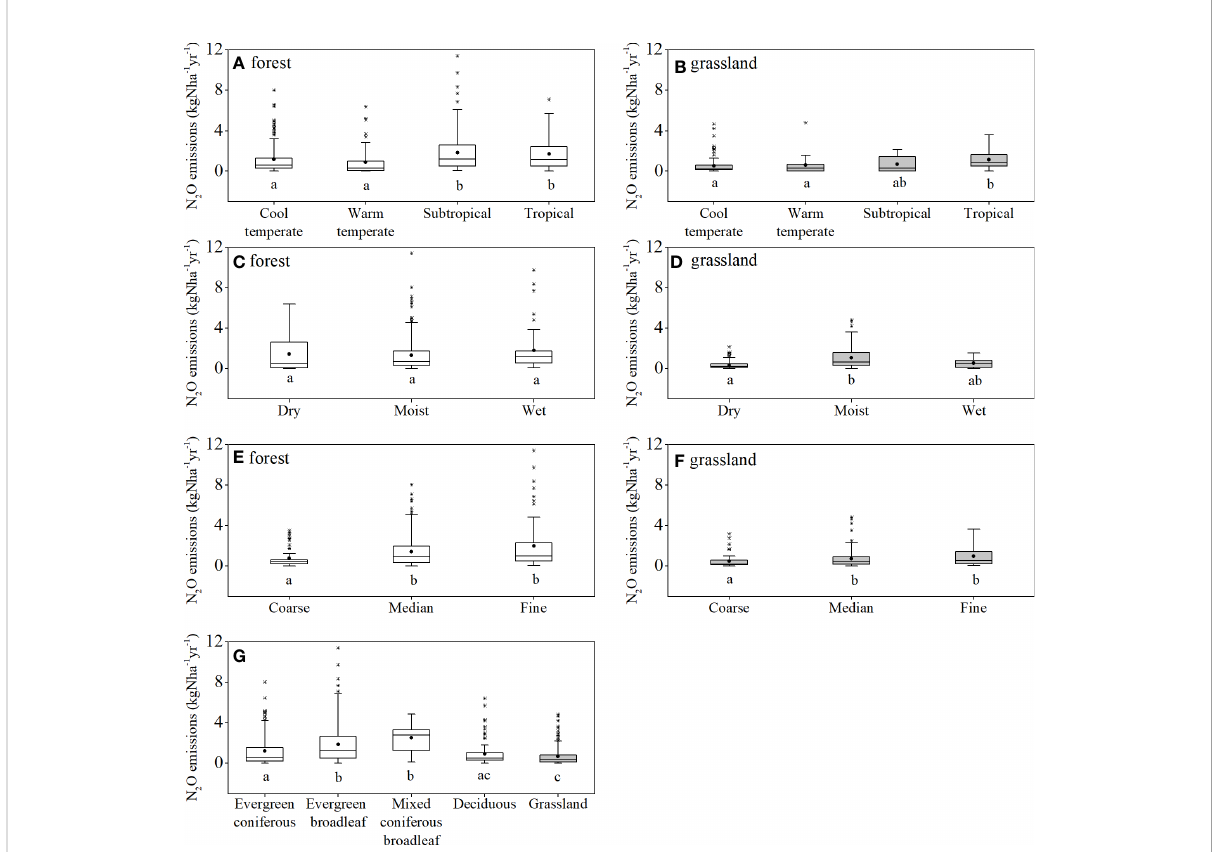
FIGURE 3 Box plot of N 2 O emissions in different climate zone, dry-wet, texture, and vegetation types. (A, C, E) are from forest, and (B, D, F) are from grassland. For (G) , the blank boxes represent forest, and the grey box represents grassland. a, b, and c represent the signi fi cant different between the median value variances. Solid circles represent averages, lines within the boxes indicated medians, and upper and lower edges of the boxes represent the 25 th and 75 th percentiles. The stars are